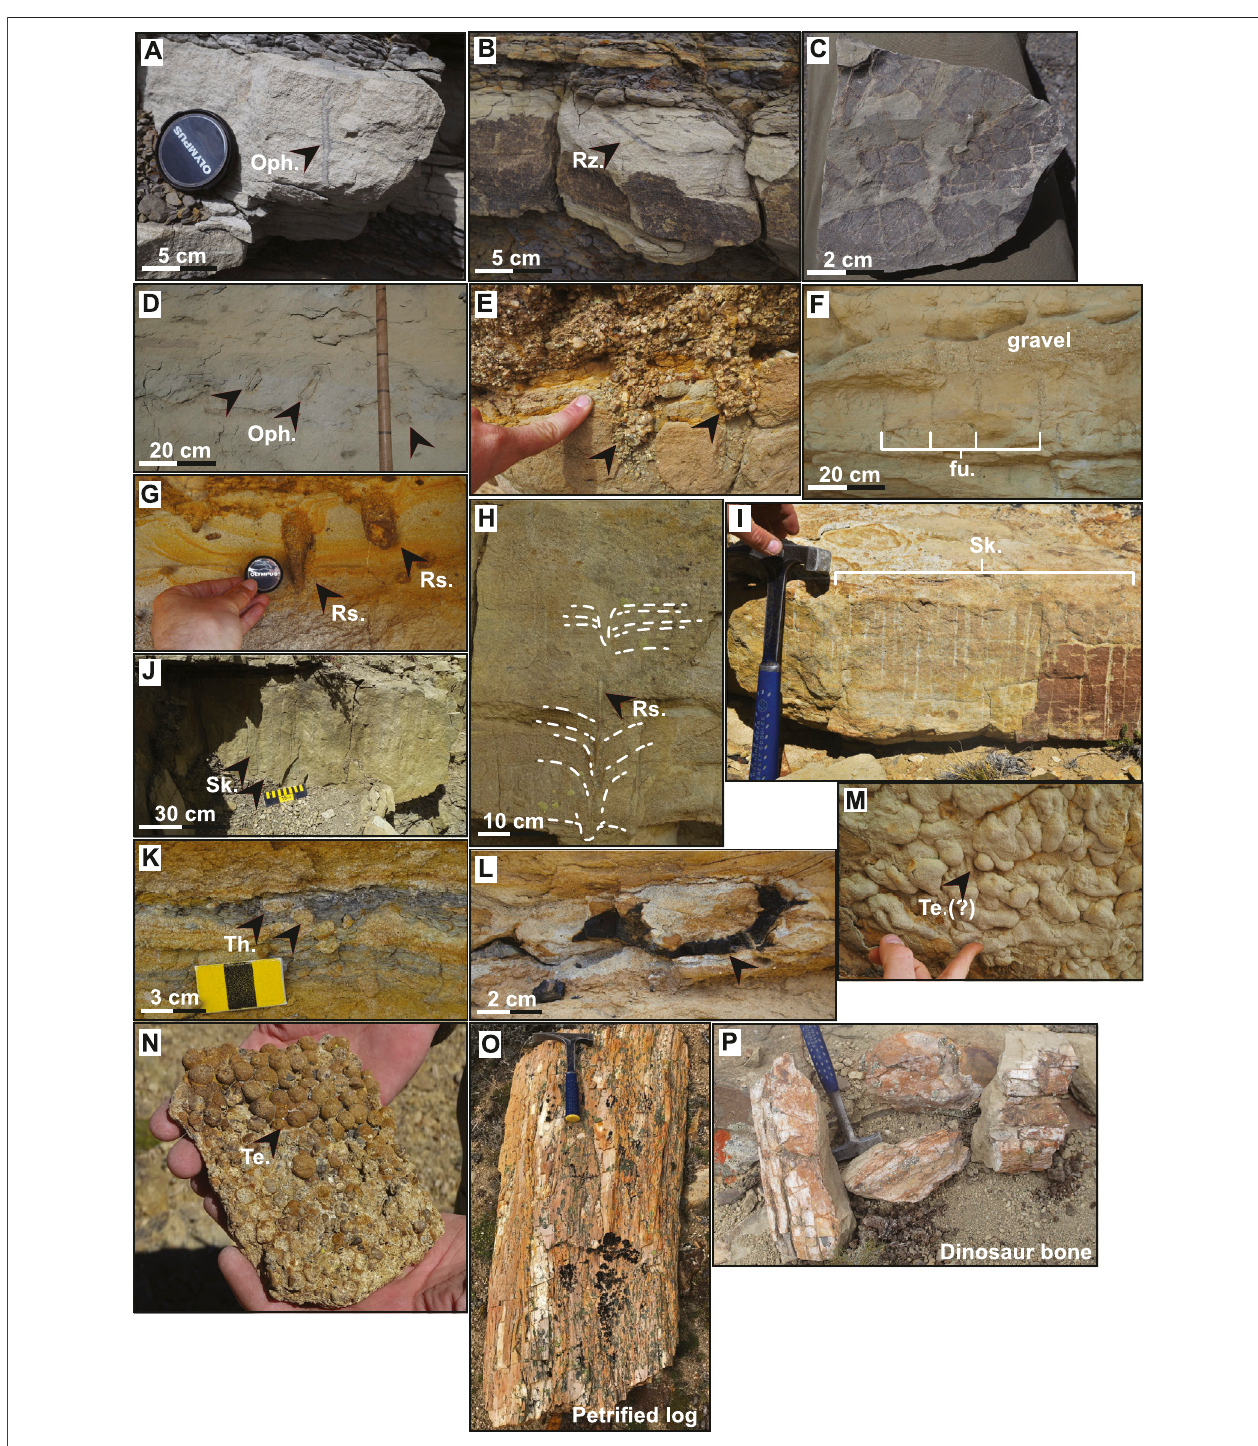
FIGURE 6 | Photographs of trace fossil and fossil assemblages from the La Anita Formation. (A) Sub-vertical, sand- fi lled, mud-lined Ophiomorpha isp .(Oph.) burrow from fi ne-grainedsandstoneofLFA-1. (B) Partially preservedsub-verticaltohorizontal sand- fi lledburrow fromLFA-1 ofpossible Rhizocorallium isp. (Rz.) af fi nity. (C) Organic plant debris on the base of a fi ne-grained sandstone bed commonly found de fi ning laminated mud partings between sandstone beds in LFA-1. (D) Sub- vertical, mud-lined and sand- fi lled Ophiomorphaisp. burrow tracescommon in highly bioturbated portions of LFA-2. (E) Escape-equilibrium fugichnia tracefossils from LFA-3 outlined by pebble conglomerate in fi lling conical burrows in underlying sandstone unit. Black arrows point to escape structures. (F) Long (~30 cm in length) escape-equilibrium fugichnia trace fossils from LFA-3 at the base of a gravel unit into a coarse-grained sandstone. (G – H) Possible Rosselia isp. (Rs.) trace fossils from